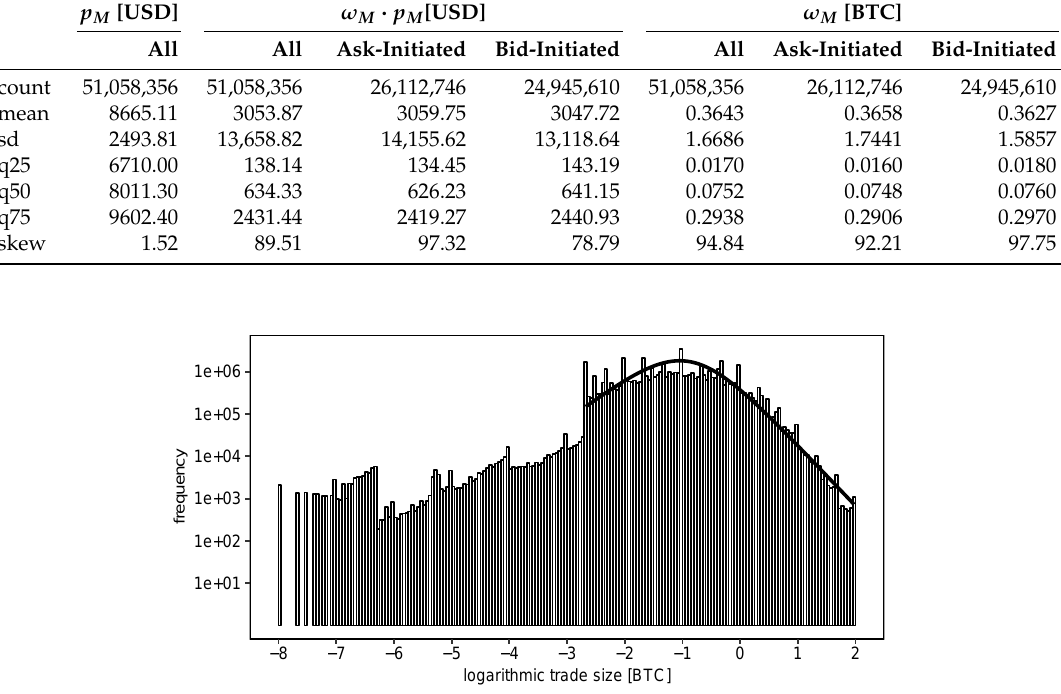
Figure 9. Distribution of trade size. We plot the empirical distribution of trade size ω M in log-log scale. The line corresponds to a fit to the q-Gamma